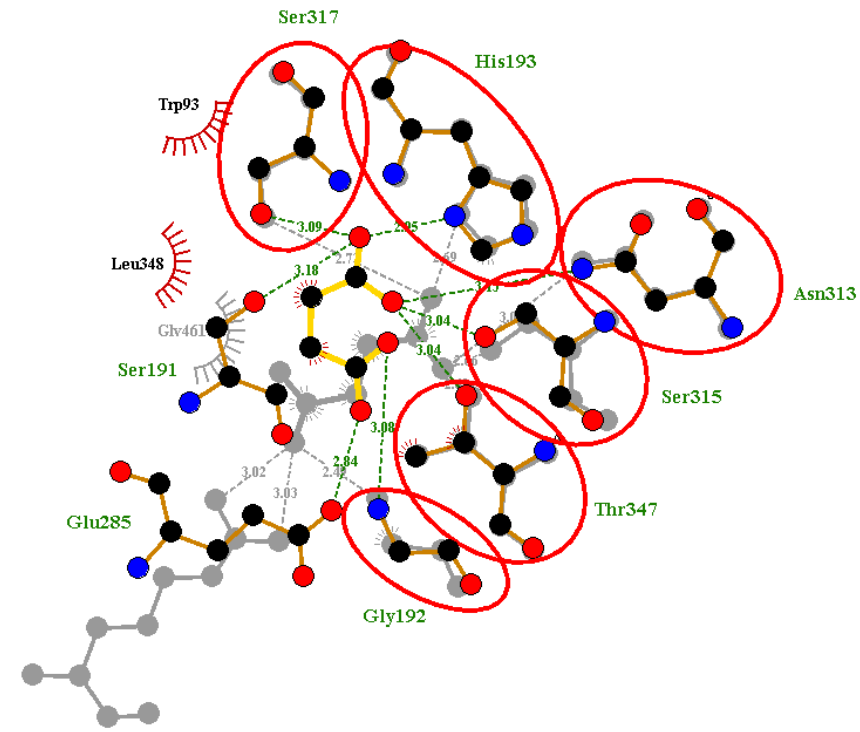
Figure 6. Superimposed Ligplots comparing the interactions between the co-crystalized ligand of 1F8I and the re-docked Succinic ligand. Residues circled in red represent the overlapped molecular interactions of both the co-crystalized ligands and the re-docked complex.